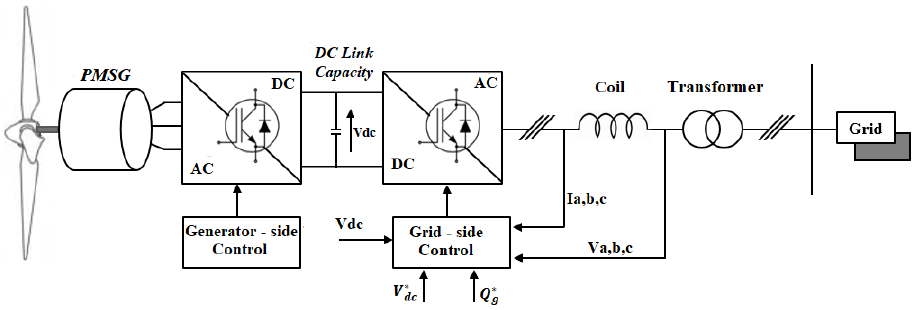
Figure 1. Structure of the grid-side conversion